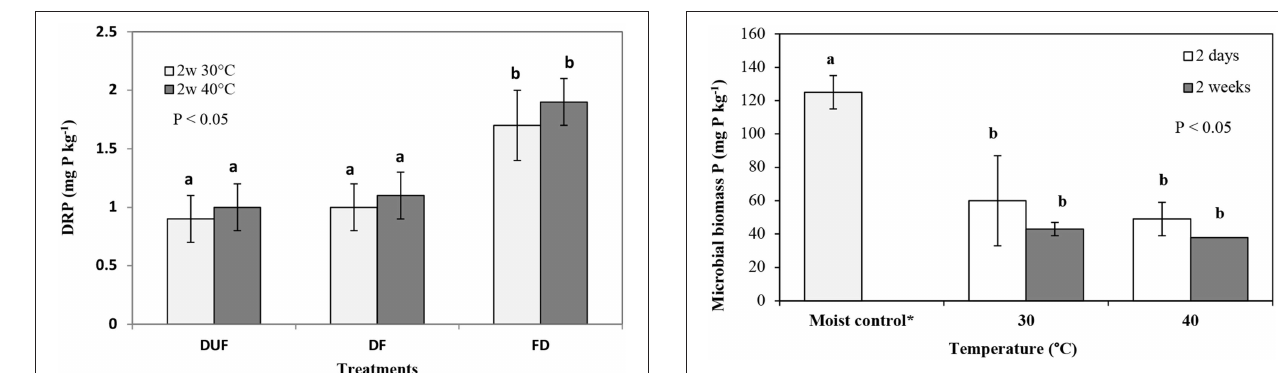
FIGURE 3 | Comparing DRP (mg P kg − 1 ) leached in 14-days drying, unfumigated (DUF), with drying followed by fumigation (DF), and fumigation followed by drying treatments (FD). Error bars represent standard deviation, n = 3. Means with the same letter are not significantly different from each other at the significance level of P < 0.05 as determined using Tukey’s post-hoc test.